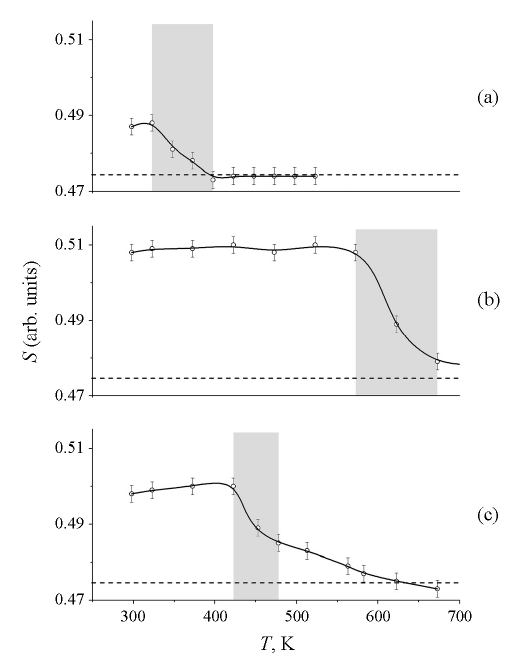
Figure 6. Recovery of the value of the S parameter (data from [11]) in the alloys ( a )—Fe-16Cr; ( b )—Fe-16Cr-Sb, and ( c )—Fe-16Cr-Au irradiated at room temperature by electrons with fluence of 5 × 10 21 m –2 . The dashed line indicates the level of the S parameter value characteristic of positron annihilation in the case of bulk Fe. Darkening marks the region of the accelerated reduction of the S parameter (added by the authors).